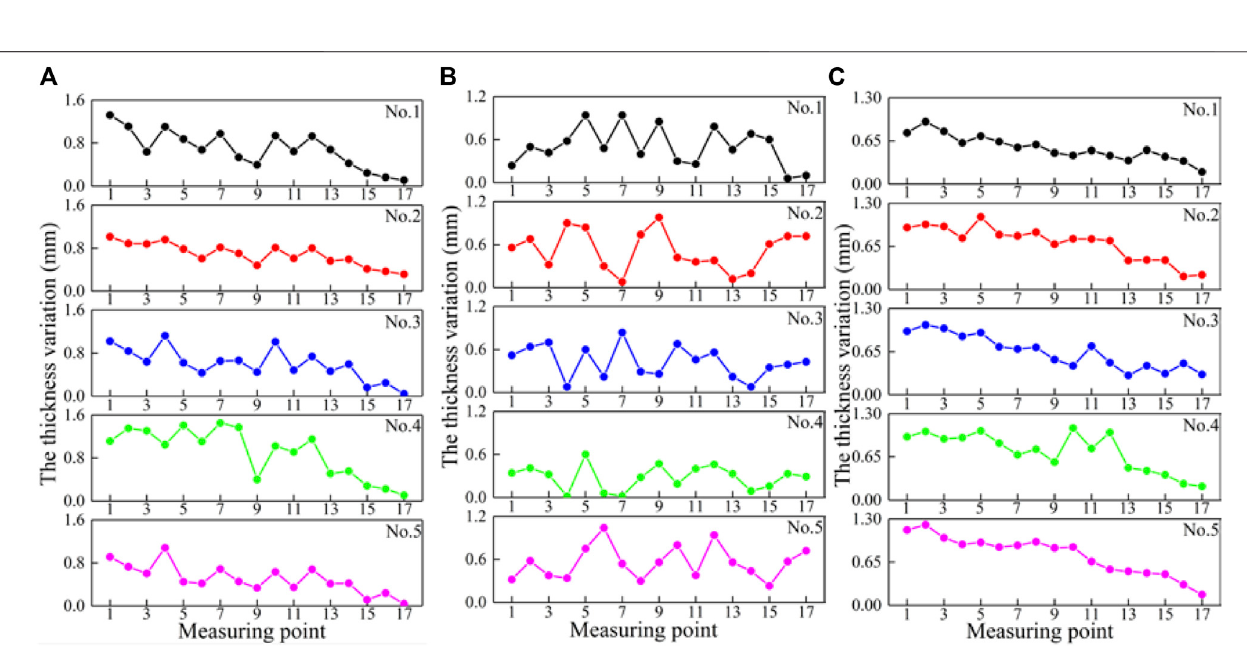
Frontiers in Energy Research |